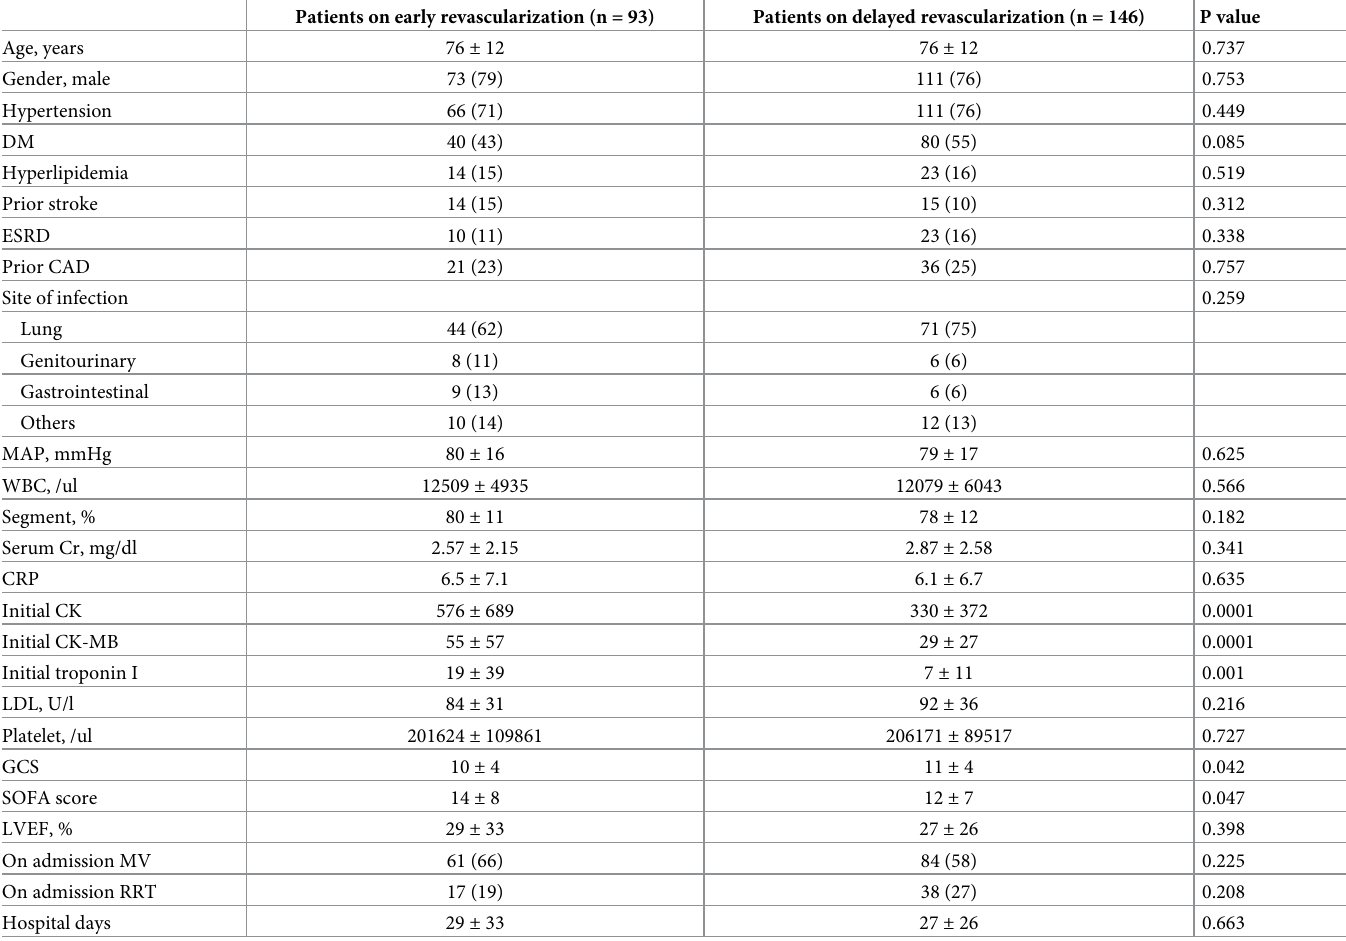
Table 1. Baseline clinical characteristics of patients receiving early and delayed